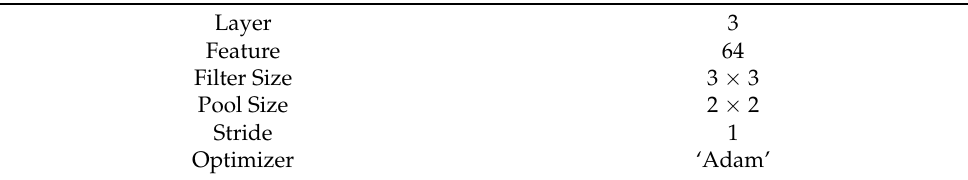
Table 1. Hyper-parameter conditions for